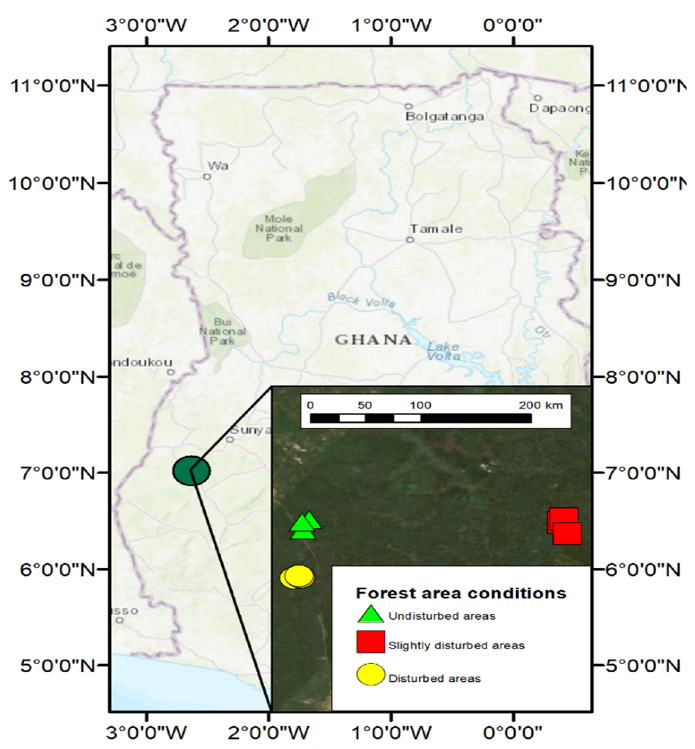
Figure 1. Locations of study areas within Bia Tano Forest Reserve of Ghana.